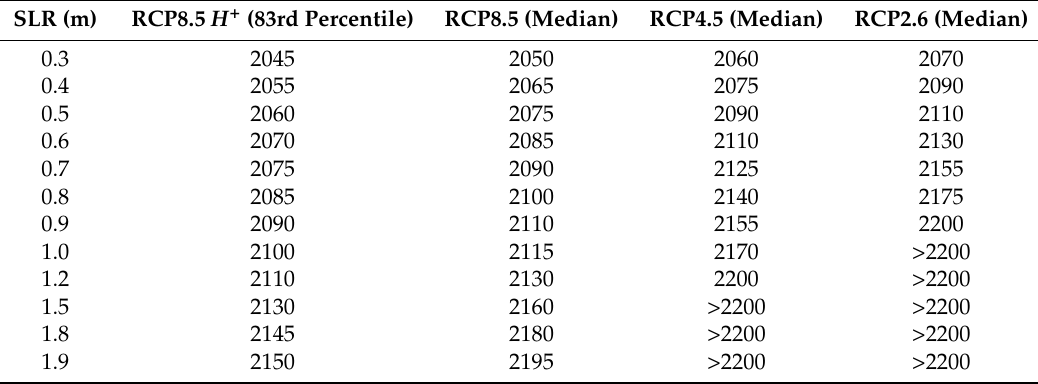
Table 1. Approximate years, from possible earliest to latest, when specific sea-level rise increments (meters above 1986–2005 baseline) could be reached for various projection scenarios of sea-level rise (SLR) for the wider New Zealand region. The earliest year listed is based on the representative concentration pathway RCP8.5 (83rd percentile) or H + projection and the next three columns are based on the median projections of the RCP8.5, 4.5 and 2.6 scenarios. SLR (m) RCP8.5 H + (83rd